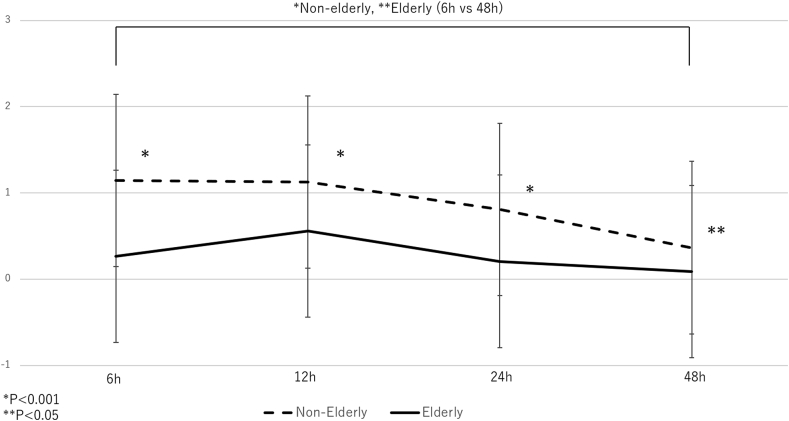
Relationship between the two groups of pain scores by treatment groups and time on study with standard deviation.